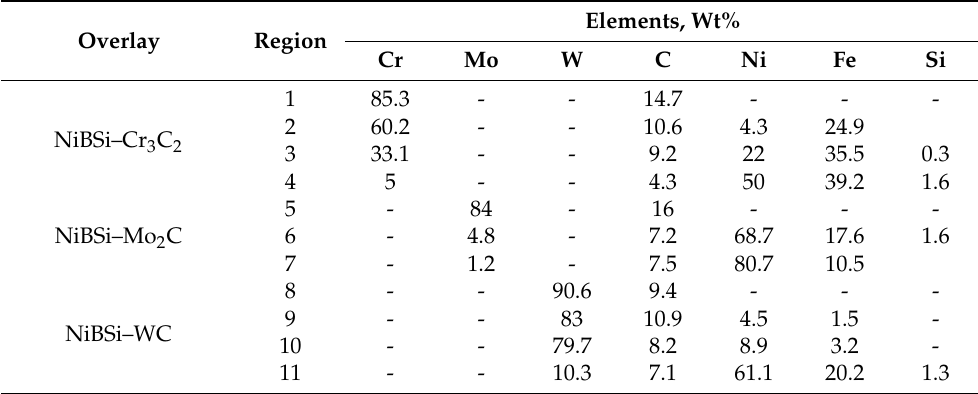
Figure 17. The structure close to the interfacial boundary ( a ) and concentration profiles of Ni, W, and Fe ( b ) in the NiBSi–WC overlay along the marked line. Table 6. Results of the EDS quantitative analysis of SCLs with Cr 3 C 2 , Mo 2 C, and WC in points marked in Figures 13a, 14a, and 16a.